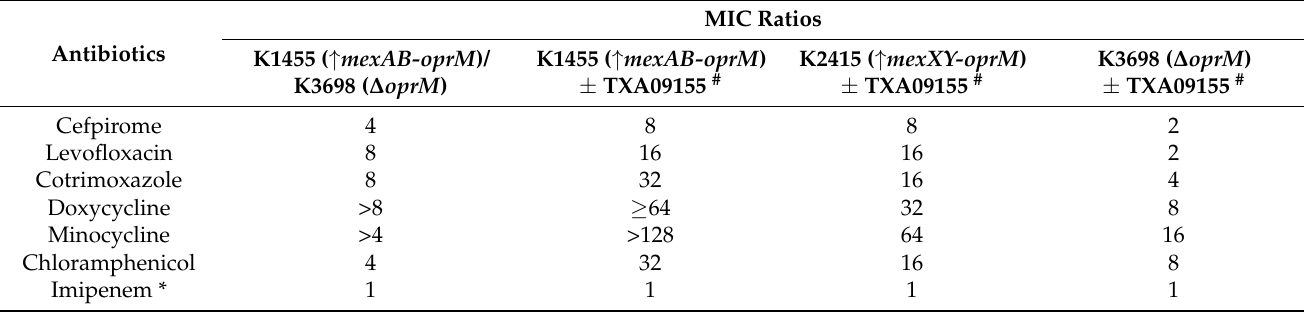
Table 3. Comparison of antibiotic potentiation by TXA09155 with the effects that pump deletion has on